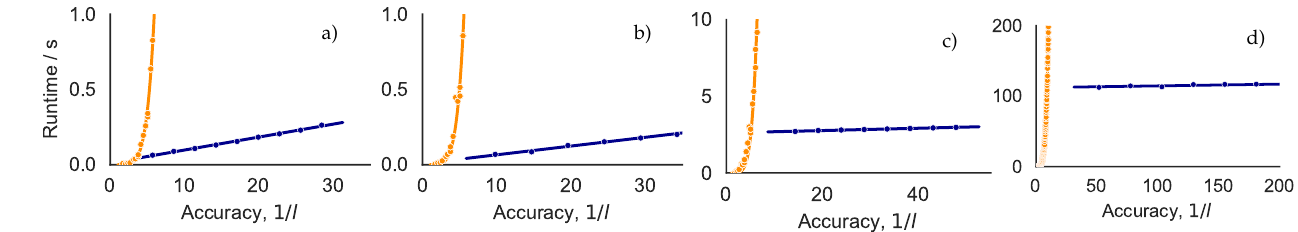
Figure 9. Minimum runtime in seconds taken experiments similar to Figure 8. Blue: DisCOptER algorithm with l c : = δτ L , linear trend line. Orange: Purely discrete, polynomial trend line of order 6. Subfigures refer to the corresponding test